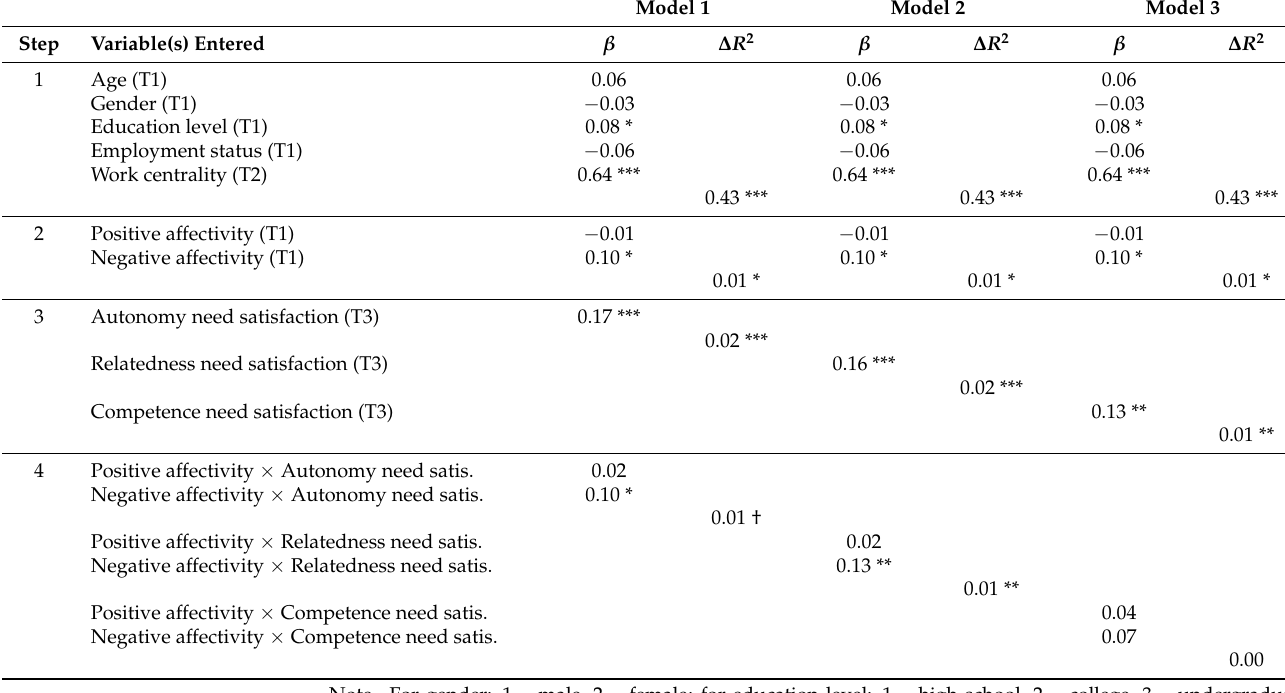
Table 4. Results of Moderated Multiple Regression Analyses Predicting Time 3 Work